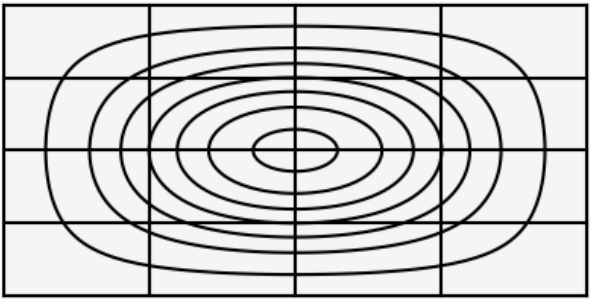
Figure 1. Overhead of the hill contour, distributed across 16 images. Fortran coarrays started out as a language extension and were formally added to the Fortran Standard in 2008 [5,6]. Coarrays are similar in concept to the MPI, but offer the advantage of a simplified syntax with square brackets [17]. A variable without square brackets will always refer to the current image’s copy of a coarray variable. Adding square brackets, such as var[i] , will allow any image to access or change the i th image’s var variable data. For instance, the following code allows the first image to send the local data in the cloud_moisture variable to the second image’s rain variable Figure 2.